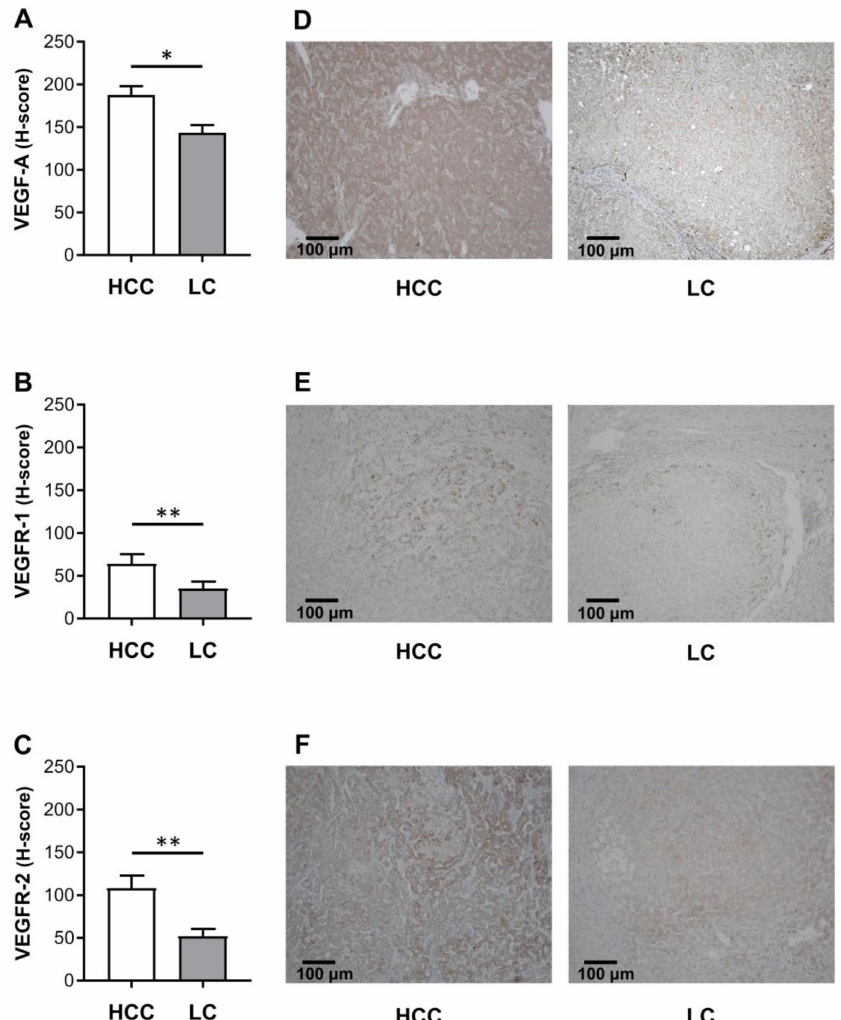
Figure 4. Protein expression of VEGF-A ( A ), VEGFR-1 ( B ), and VEGFR-2 ( C ). IHC was run in tumoral and cirrhotic liver tissue specimens ( n = 26). Semi-quantitative evaluation by H-score, expressed as mean ± SEM. Specimens ( D – F ) are representative examples of 26 HCC and 26 paired LC tissue samples (original magnification 100 × ). Statistical analysis included data on all patients. The p values were obtained by paired t test (* p < 0.05, ** p <